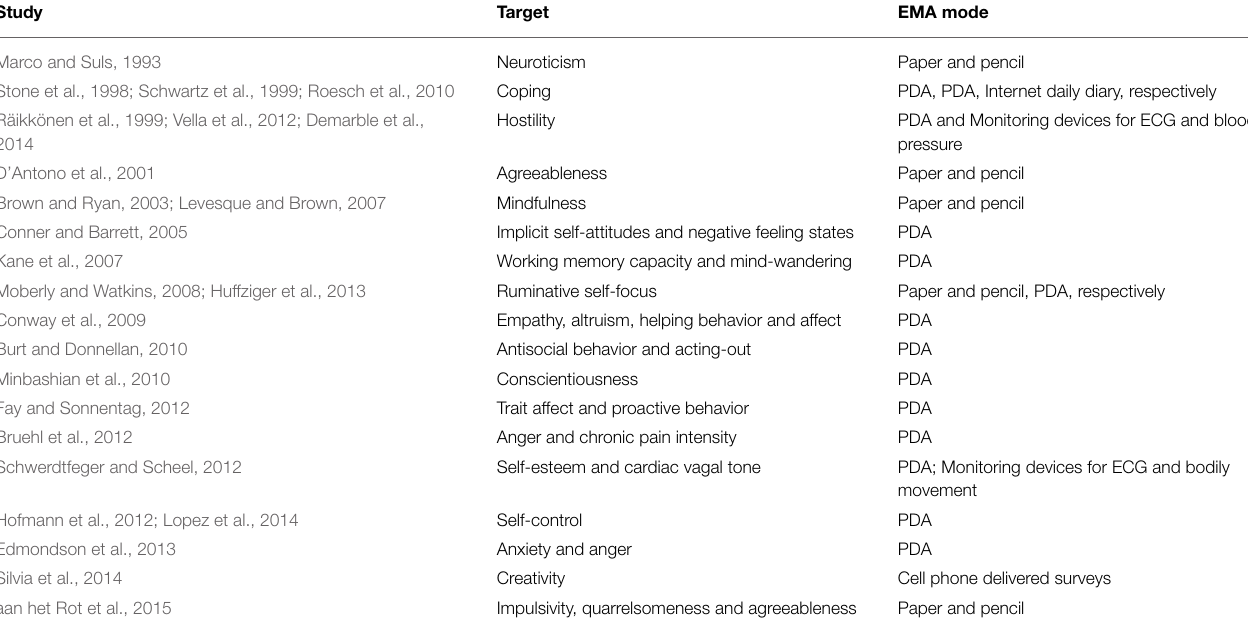
TABLE 2 | EMA peer-reviewed psychological studies targeting momentary dispositional expression within non-clinical populations.